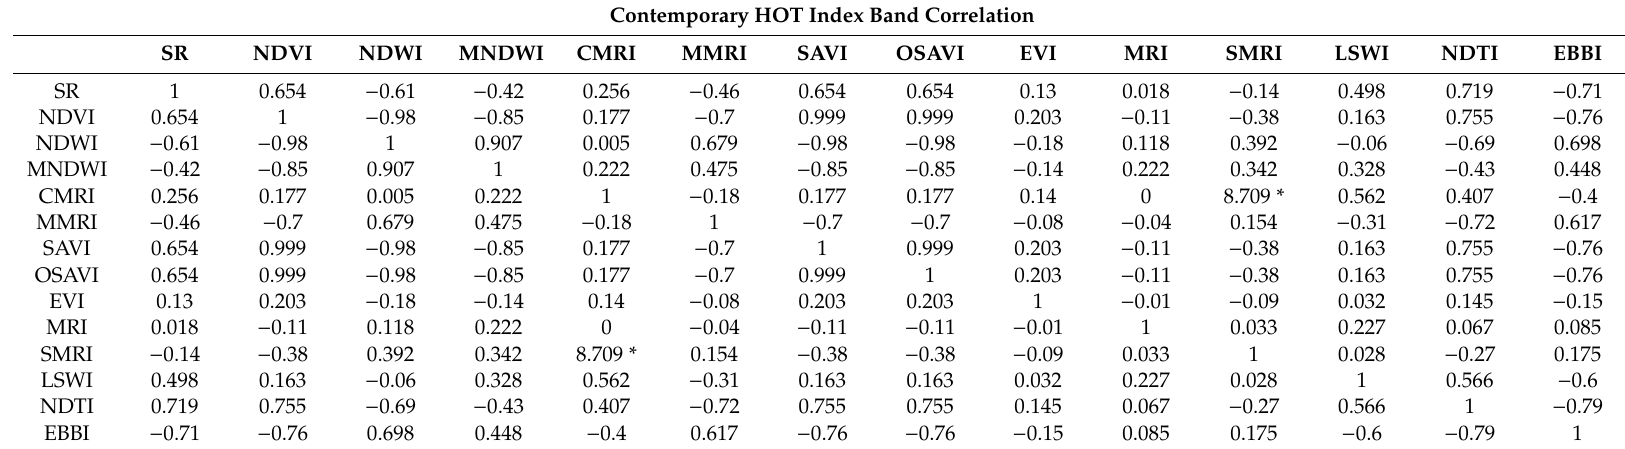
Table A1. Correlation matrices for the calculated spectral indices for both HOT and LOT historic and contemporary imagery extracted from the